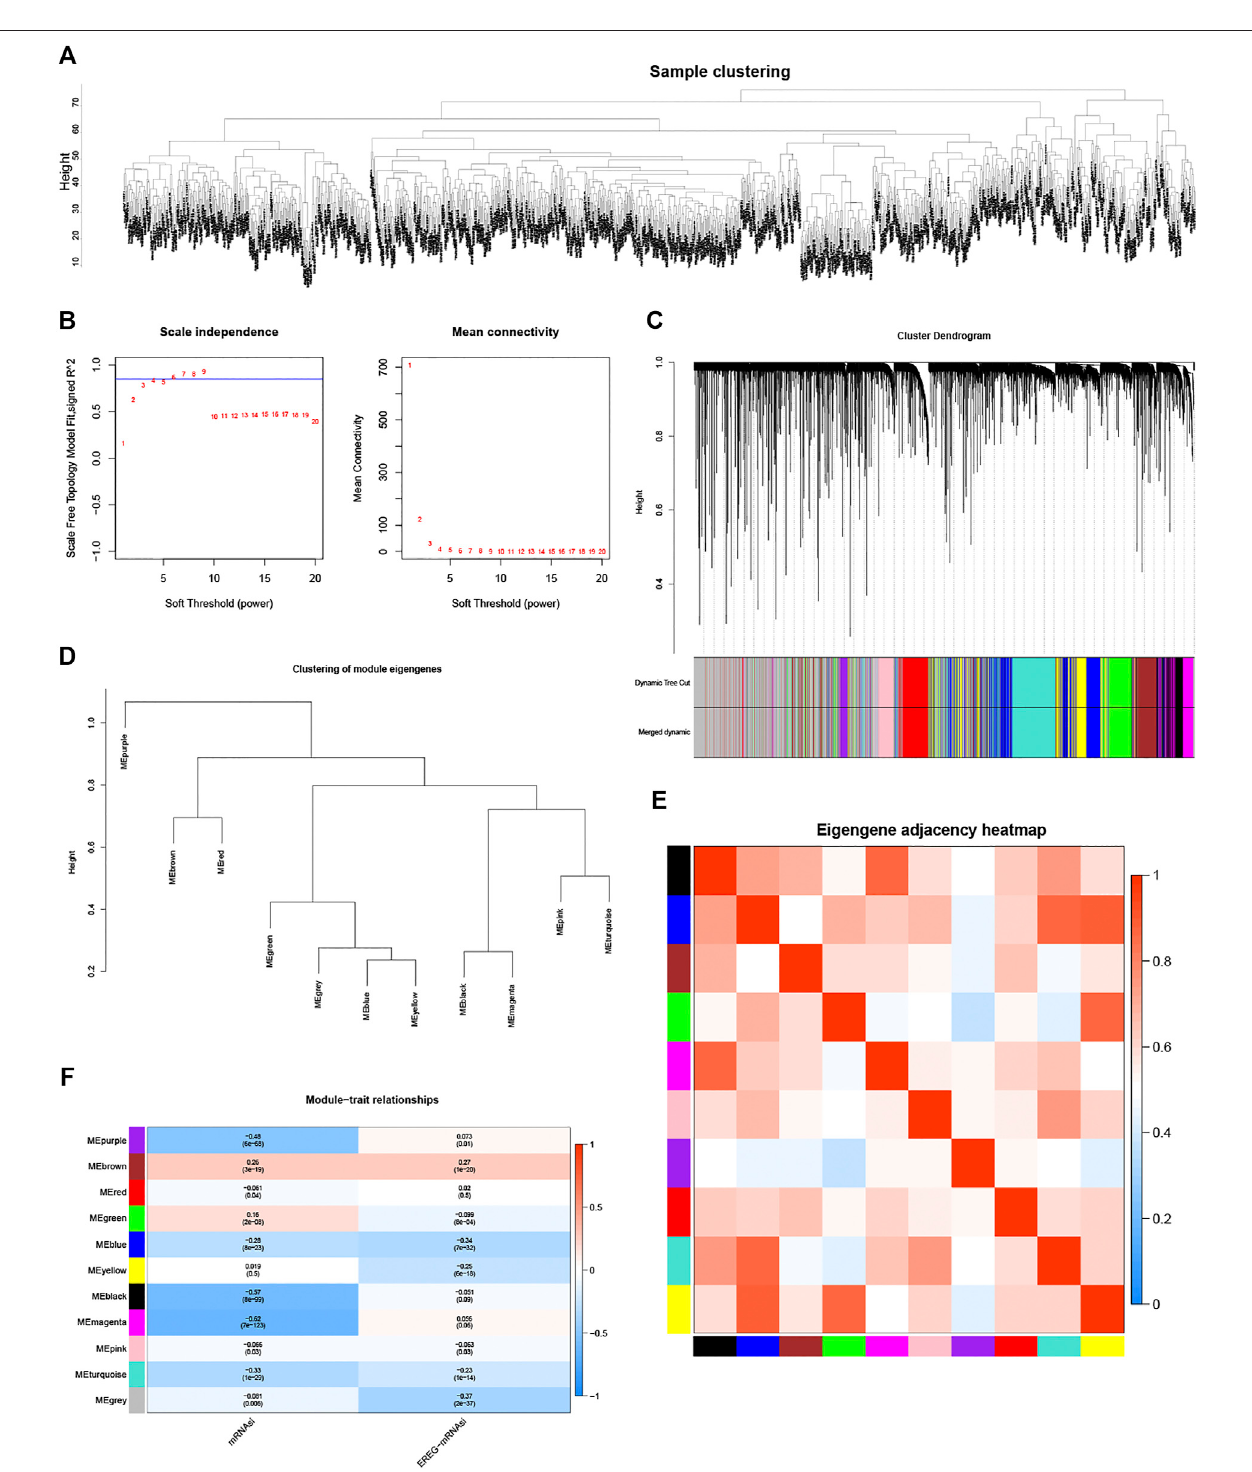
FIGURE 1 | Identi fi cation ofstemness-index-related module and lncRNAs based on WGCNA. Samples clustering analysis to remove outliers (A) , determination of soft threshold and inspection of scale-free network (B) , 11 modules were identi fi ed and presented in different colors by setting MEDissThres as 0.2 and minModuleSize as 30 (C) , 11 modules were grouped into four clusters by correlation analyses (D) , purple module has lowest correlation with other modules (E) , and magenta module was most signi fi cantly negatively correlated with mRNAsi ( p < .05 and correlation coef fi cient = − 0.62) (F) .